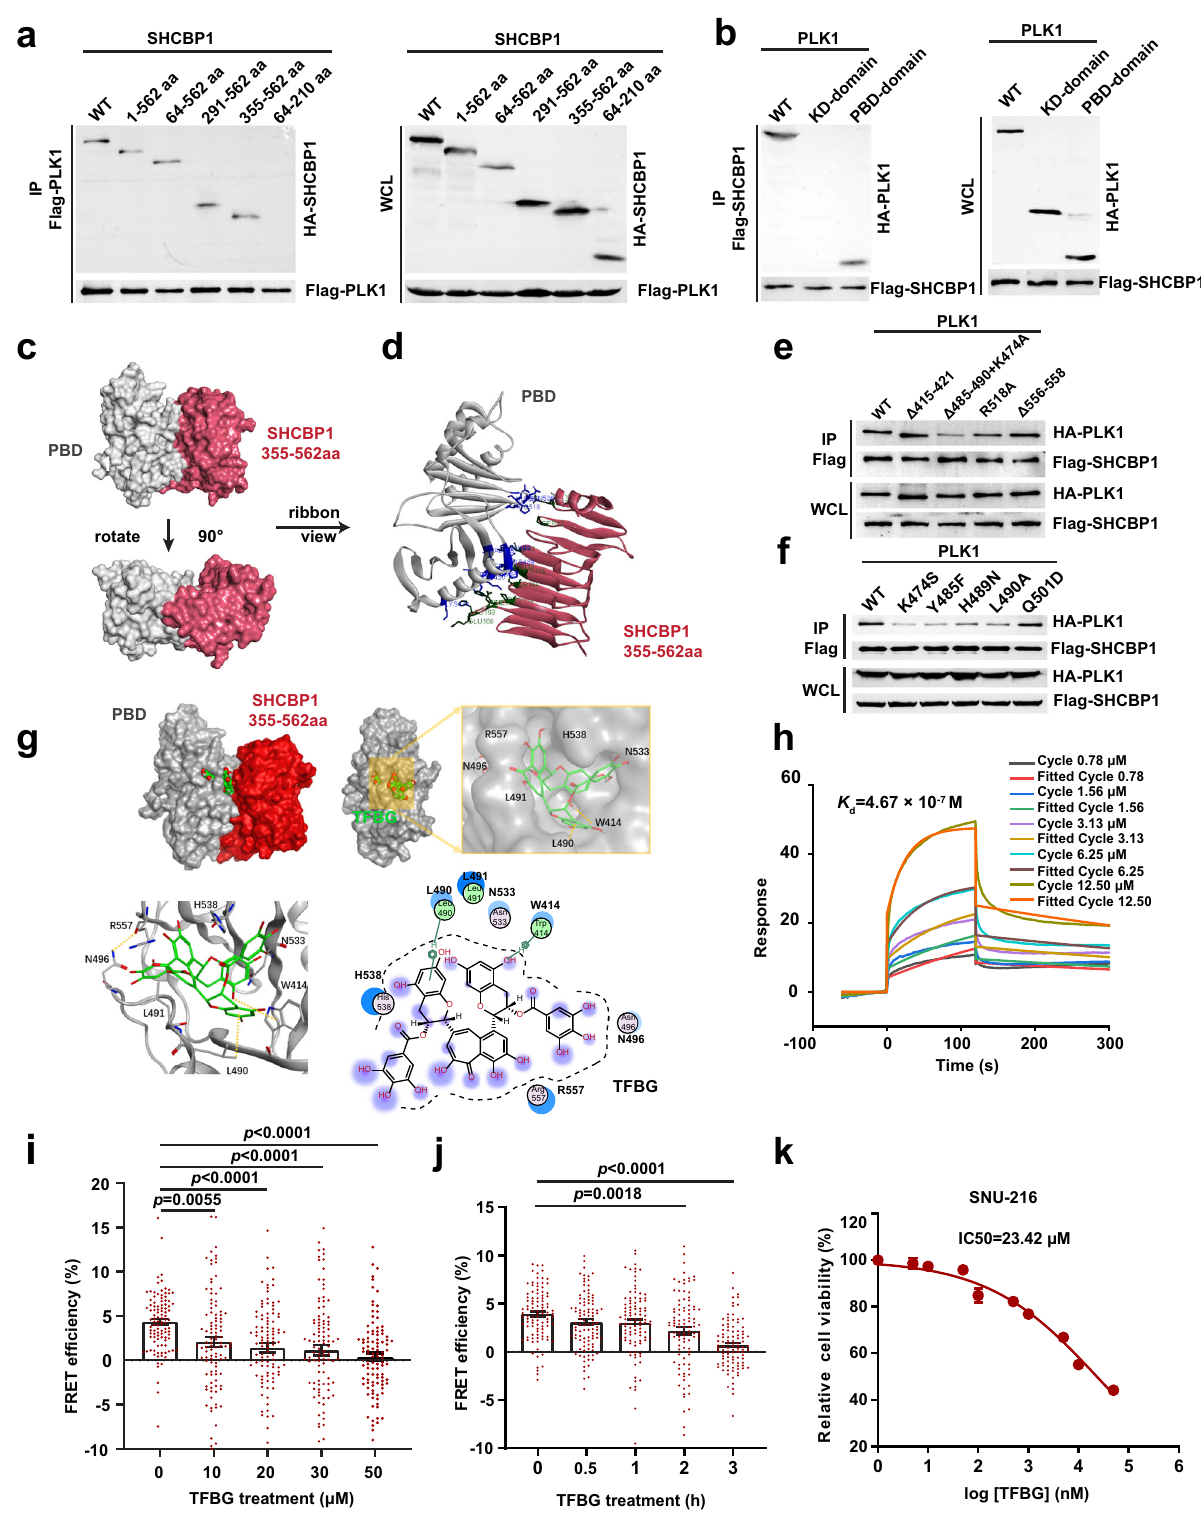
agent renders gastric cancer sensitive to HER2-directed therapy, providing additional combination therapy in HER2-positive patients with advanced gastric